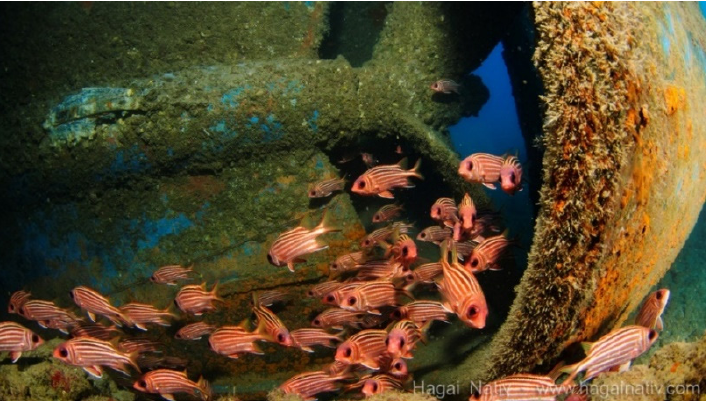
Figure 5. Part of a shipwreck that is an artificial habitat attracting Lessepsian red squirrelfish ( photograph by Hagai Nativ).